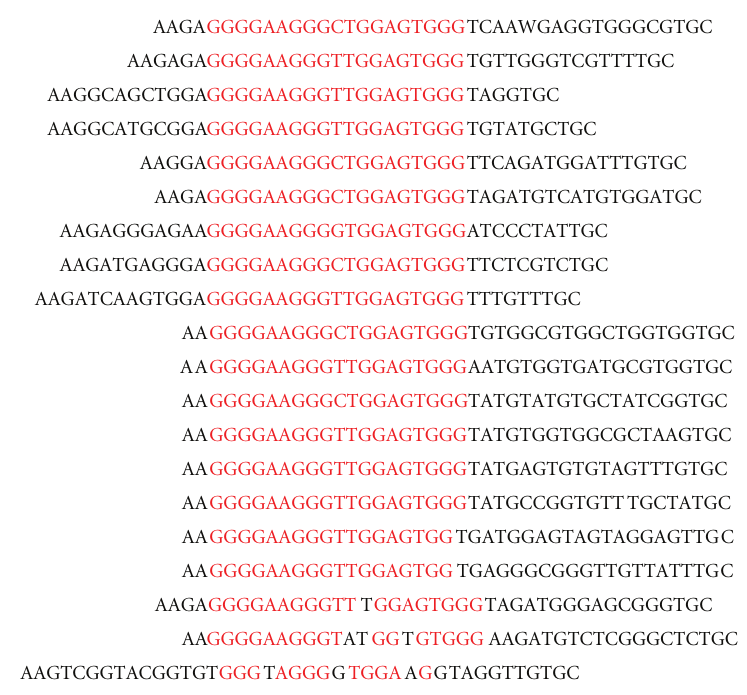
Figure 2: The consensus sequence obtained for RPA-CDE after SELEX, GGGGAAGGGYTGGAGTGGGT (Y = T/C), was present in 63% of all sequences analyzed. Red letters indicate alignment from the trinucleotide